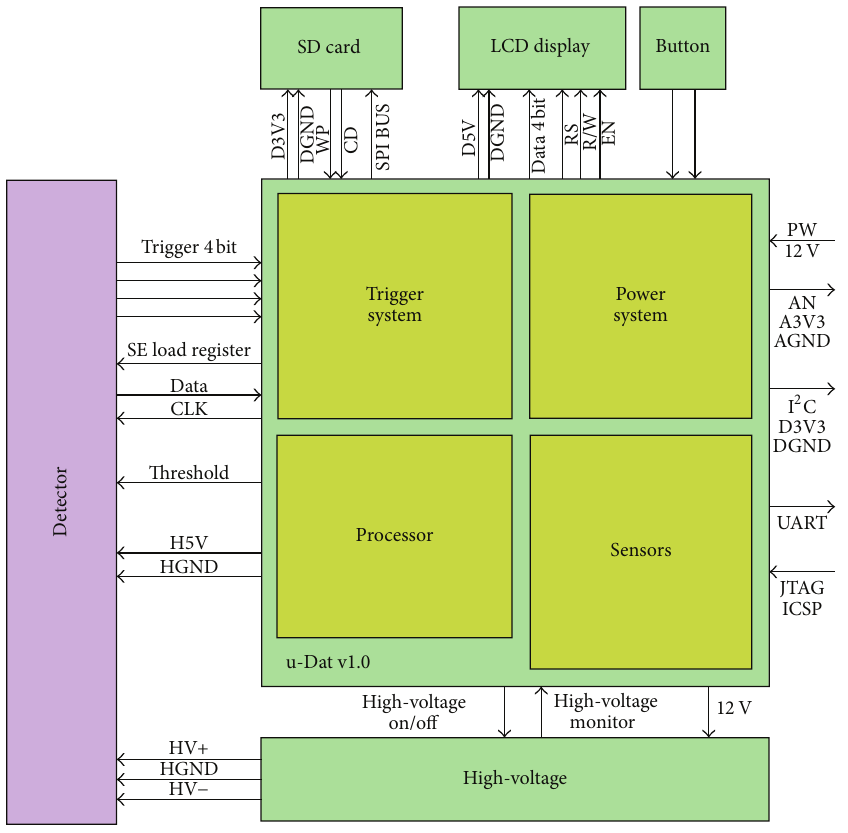
Figure 4: The schematic plan of the electronics system of the Muontomograph, including data acquisition, low- and high-voltage power system, and Human-Machine Interface block (LCD display, control buttons, and SD card access) [5,